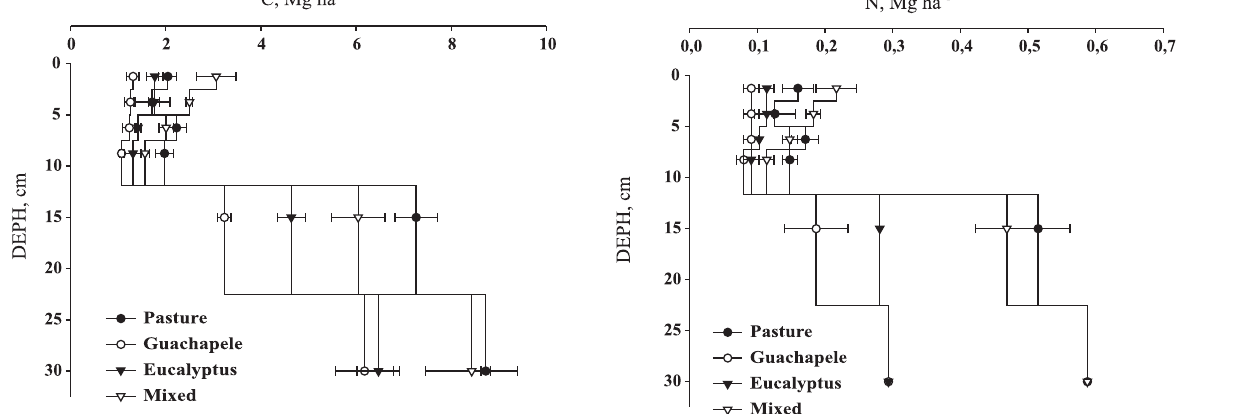
Figure 1. Estimates of C stocks in different soil layers (0–2.5, 2.5–5.0, 5.0–7.5, 7.5–10.0, 10–20 and 20– 40 cm) under pasture and pure and mixed plantations of Eucalyptus grandis and Pseudosamanea guachapele . Bars indicate standard errors of means.